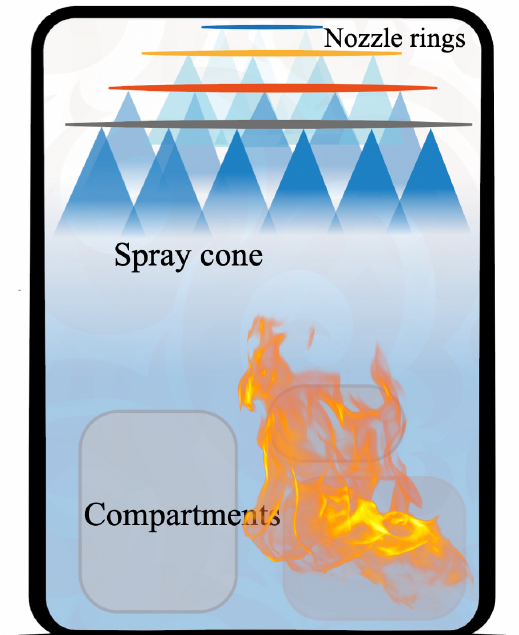
Figure 1. A sketch of the spray system for fire mitigation in an industrial